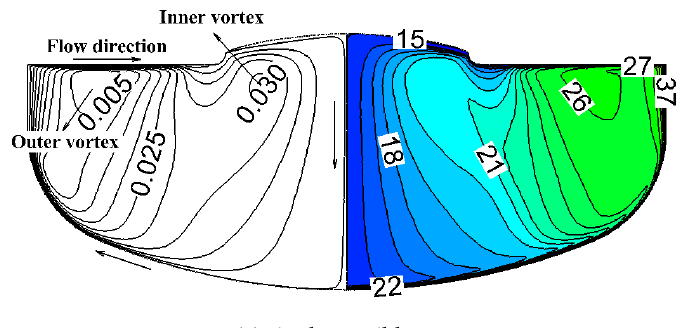
0.00 0.02 0.04 0.06 0.08 0.10 0.12 0.14 0.16 0.18 0.20 39.039.5